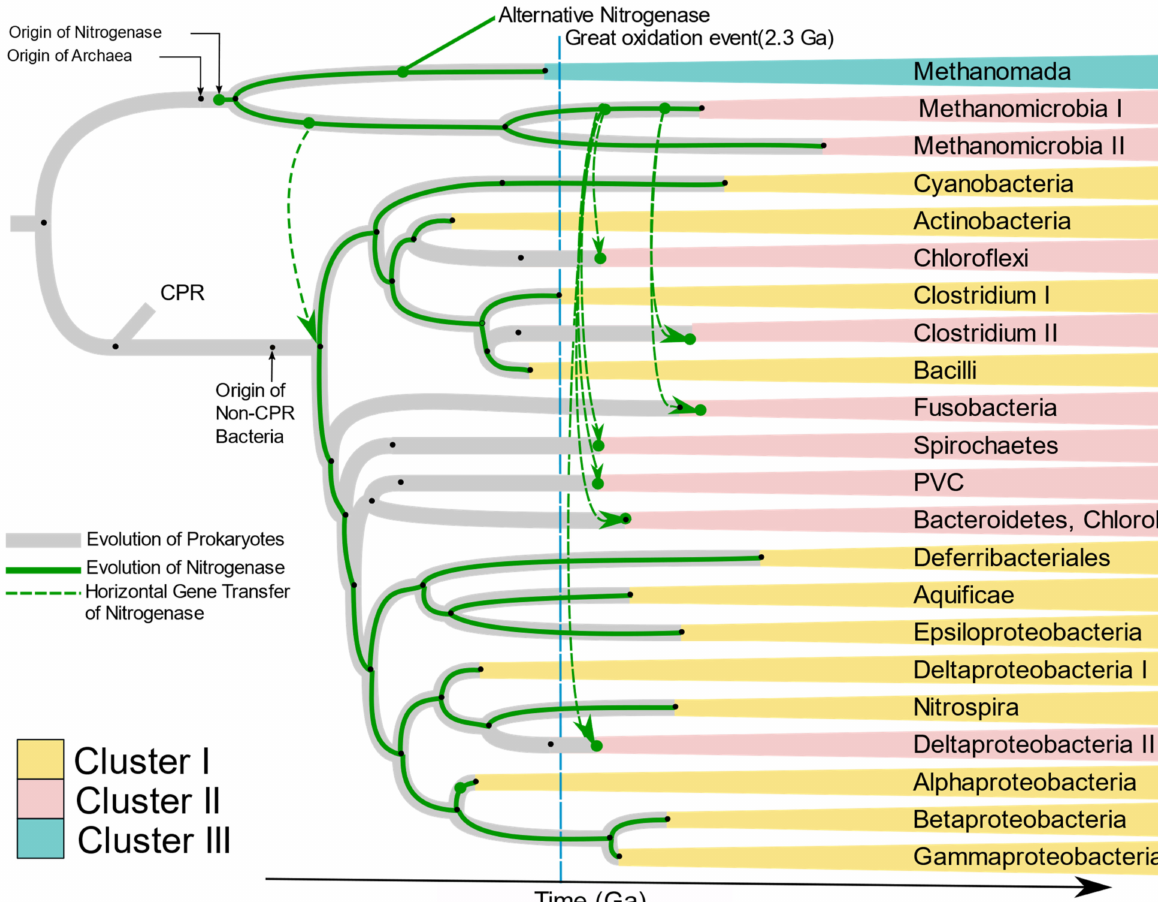
Figure 10. Proposed evolution of Diazotrophs. The gray tree represents the chronogram of prokaryotes while the green tree represents the proposed evolution of nitrogenase. The dashed green lines indicate horizontal gene transfer as supported by homology of NifHDKENB sequences. Black dots indicate origin of the respective phyla or groupings. The evolutionary timescale is based on Zhu et al., 2019 [26]. The Methanomada clade in Euryarchaeota includes orders Methanobacteriales and Methanococcales . Methanomicrobia I includes the orders Methanocellales and Methanomicrobiales . Methanomicrobia II includes Methanosarcinales . Clostridium I includes the family Peptococcaceae , Clostridium II includes Clostridia and Negativicutes. Deltaproteobacteria I includes Myxococcales , and Deltaproteobacteria II includes other